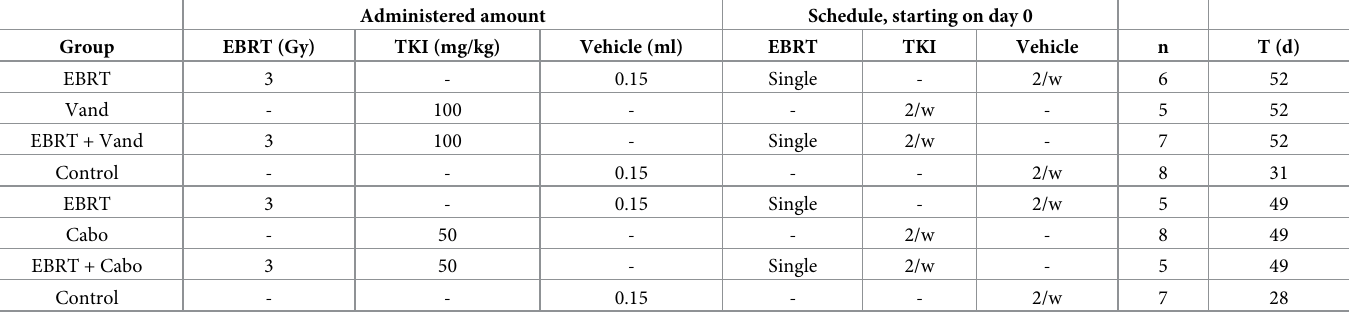
Table 1. Treatment schedules. BALB/c nude mice carrying patient-derived medullary thyroid cancer (GOT2) were treated with the presented amounts and schedules of external beam radiotherapy (EBRT) and/or tyrosine kinase inhibitors (TKIs) vandetanib (Vand) or cabozantinib (Cabo), or a mock-treatment vehicle (solvent for vandeta- nib/cabozantinib). The vehicle volume (0.15 ml) was chosen to be similar to the administered volume for TKI treatment (0.15–0.20 ml depending on body